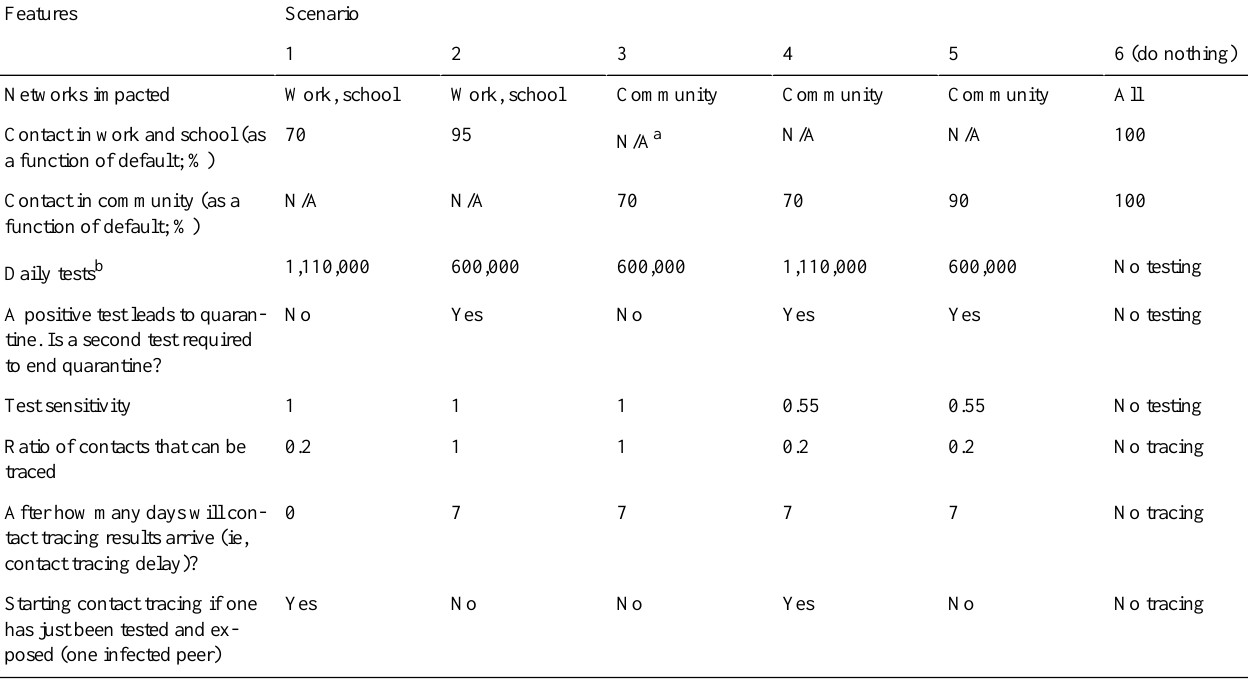
Table 2. Scenarios depicting concurrent nonpharmaceutical interventions, chosen for their ability to create five markedly different outcomes together with a nonintervention case.